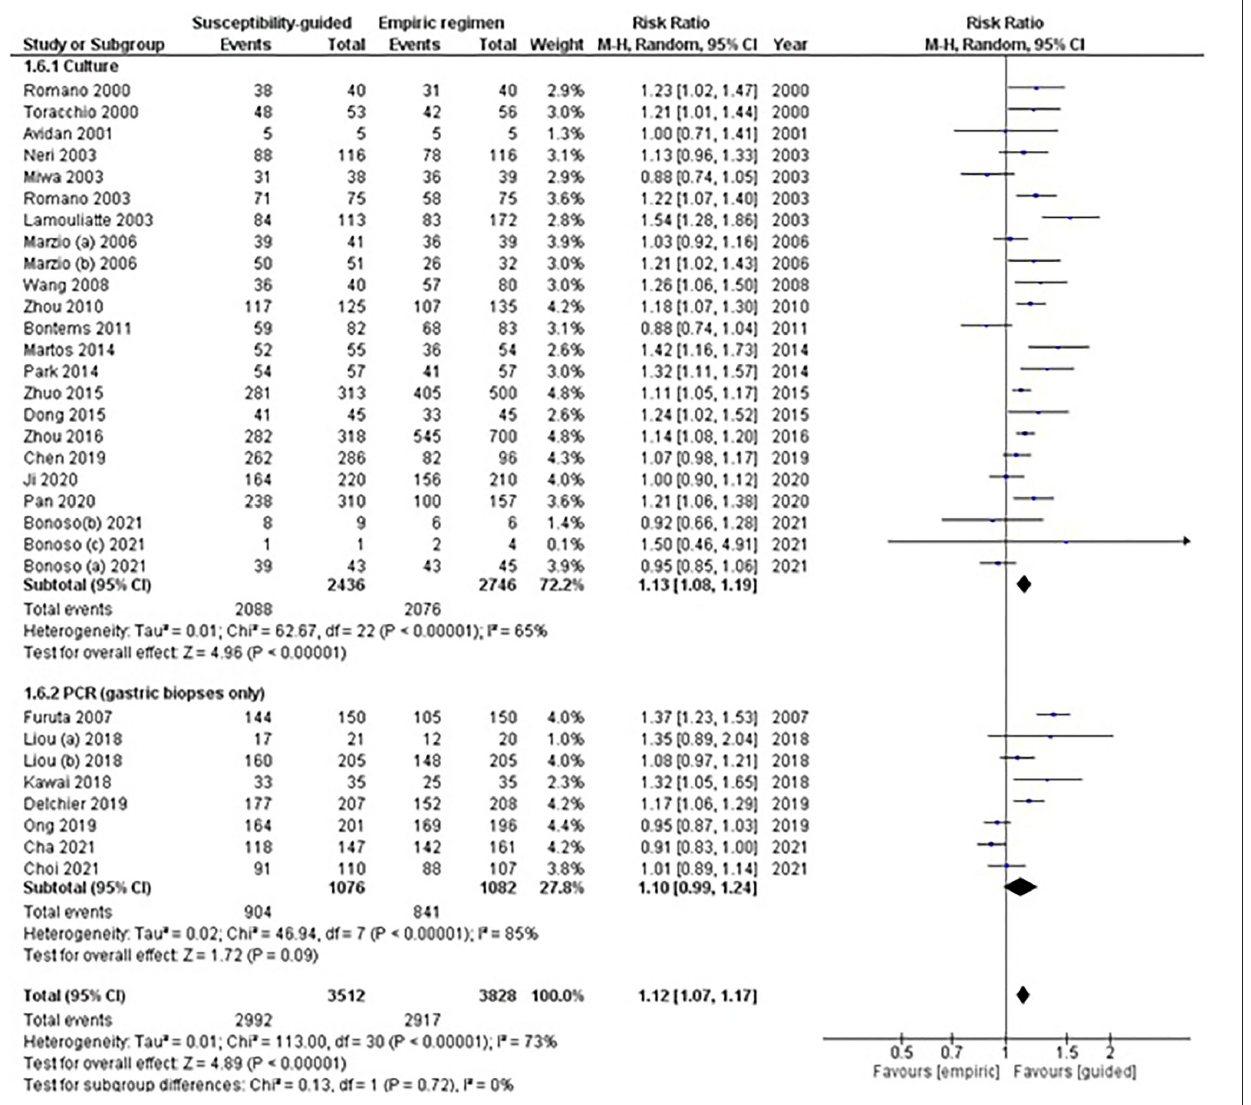
that susceptibility-guided therapy was superior to first-line resistance exceeded